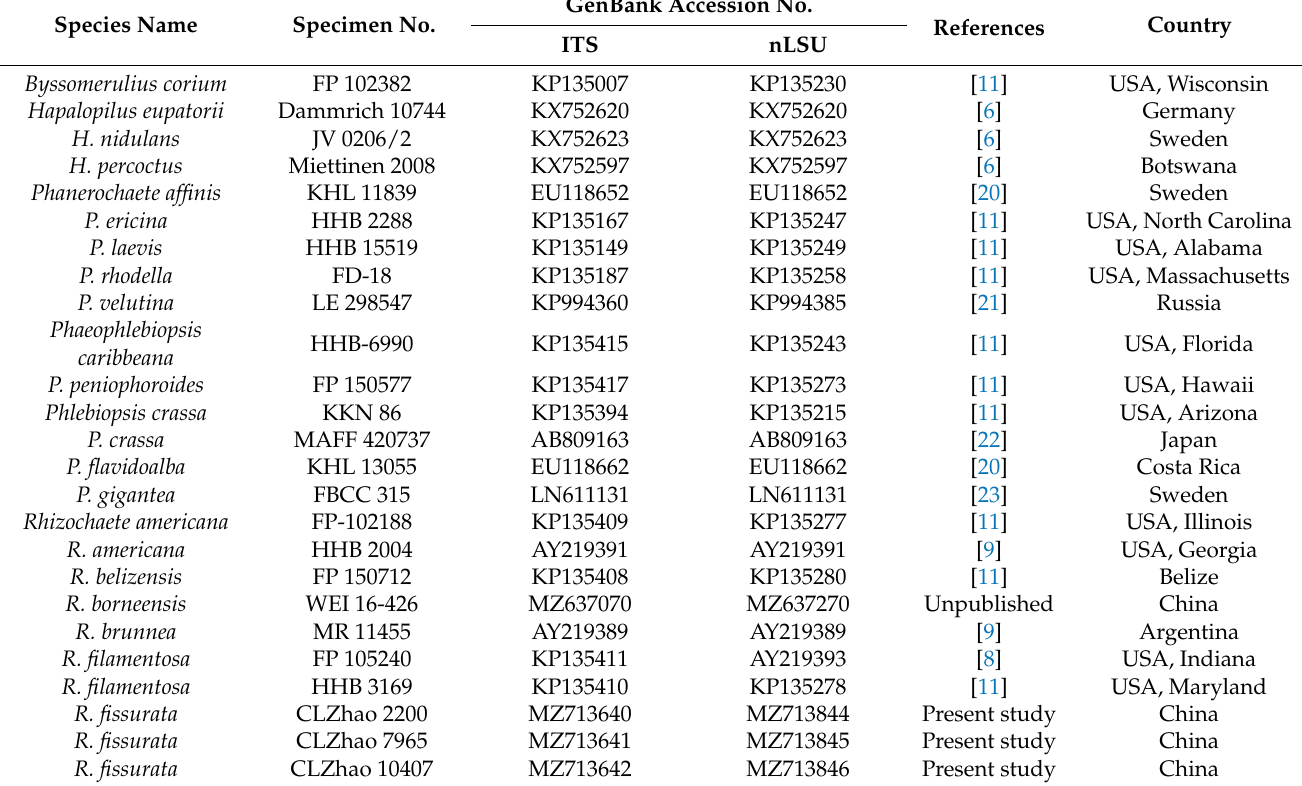
Table 1. List of species, specimens, and GenBank accession numbers of sequences used in this